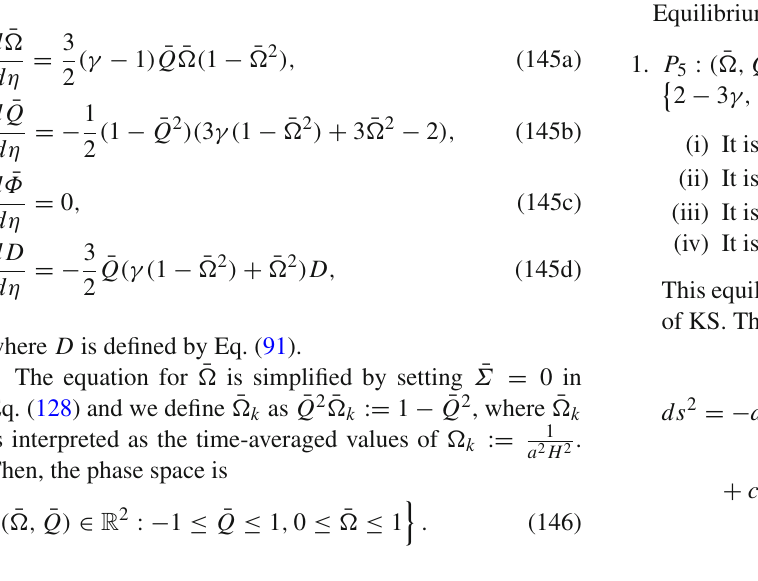
Fig. 6 Phase space of the guiding system (127a)–(127c) corresponding to KS for barotropic index γ =